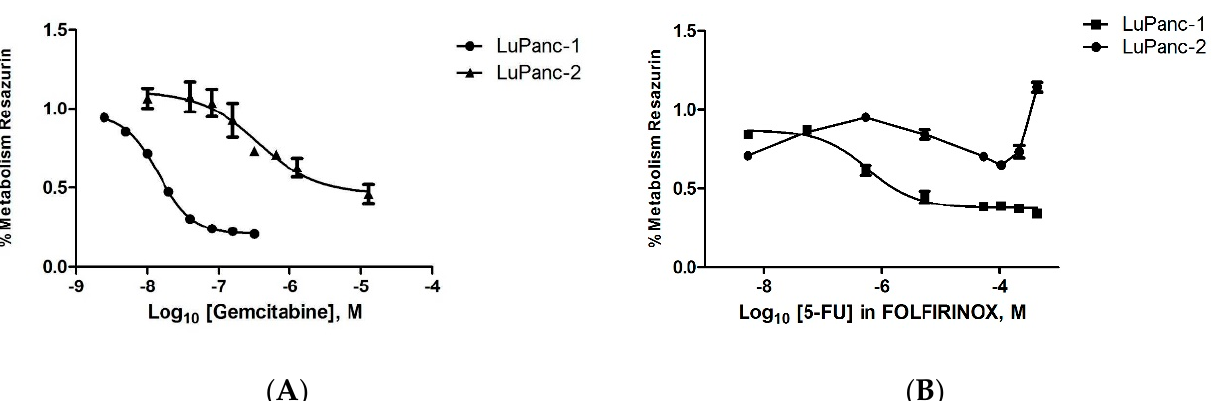
Figure 7. Evaluation of the proliferative response of LuPanc-1 and LuPanc-2 cells to gemcitabine or FOLFIRINOX. Both cell lines were treated with either gemcitabine ( A ) or FOLFIRINOX ( B ), followed by the addition of Resazurin and OD measurement.